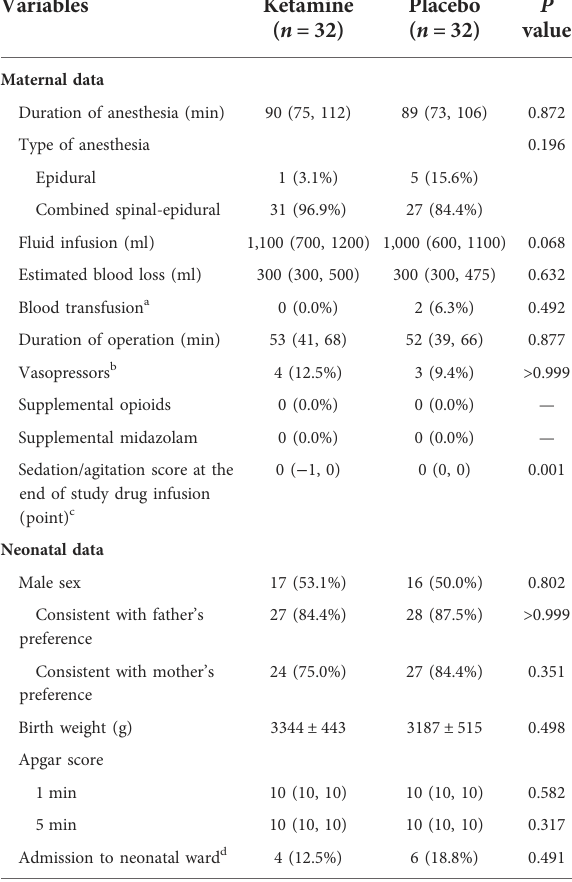
TABLE 2 Intraoperative